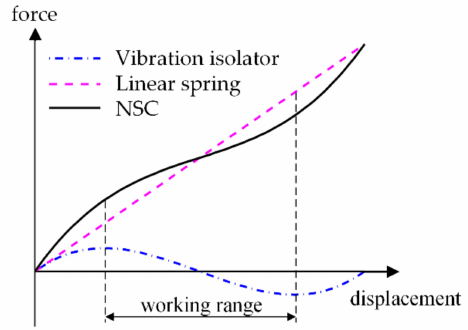
Figure 2. Force-displacement curves of linear supporting spring, NSC, and the vibration isolator they